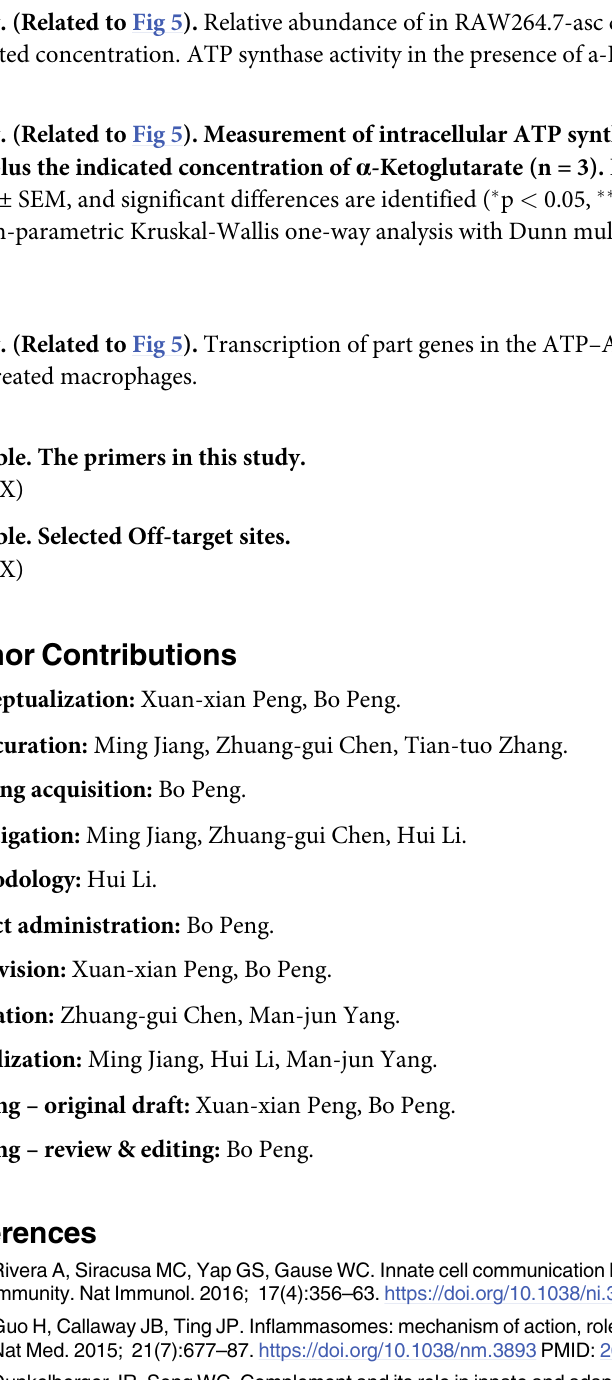
S6 Fig. (Related to Fig 3). qRT-PCR for expression of il1b (A) and c3 (B) in th presence of LPS, inosine or succinate. Results are displayed as mean ± SEM, and significant differences are identified ( � p < 0.05, �� p < 0.01) as determined by non-parametric Kruskal-Wallis one- way analysis with Dunn multiple comparison post hoc test for results. S7 Fig. (Related to Fig 5). Relative abundance of in RAW264.7-asc cells exposed to LPS at the indicated concentration. ATP synthase activity in the presence of a-KG. S8 Fig. (Related to Fig 5). Measurement of intracellular ATP synthase activity using cell lysis plus the indicated concentration of α -Ketoglutarate (n = 3). Results are displayed as mean ± SEM, and significant differences are identified ( � p < 0.05, �� p < 0.01) as determined by non-parametric Kruskal-Wallis one-way analysis with Dunn multiple comparison post hoc test. S9 Fig. (Related to Fig 5). Transcription of part genes in the ATP–AMP salvage pathway in LPS-treated macrophages. S1 Table. The primers in this study. S2 Table. Selected Off-target